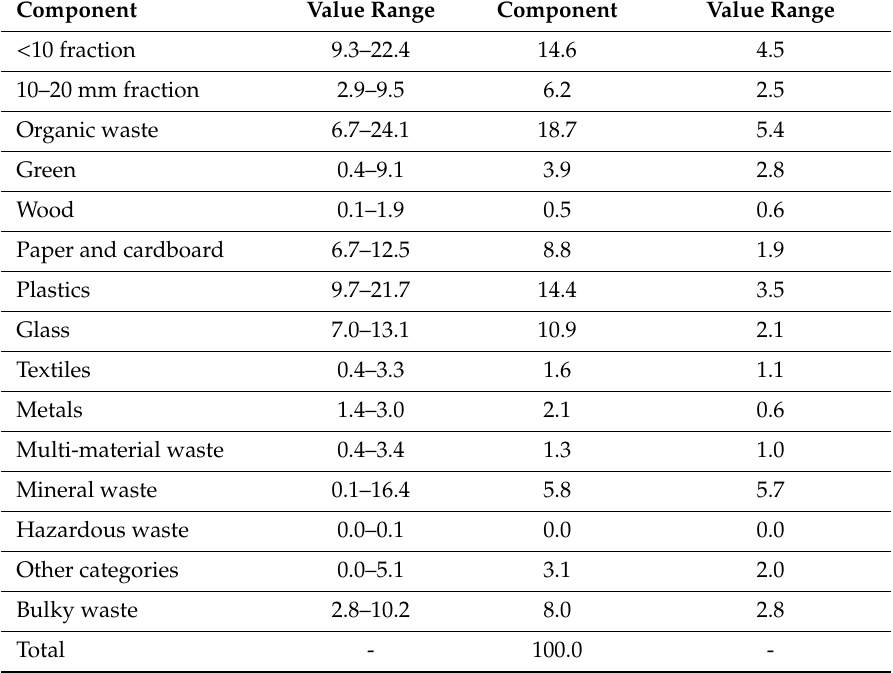
Table 2. Morphological composition of